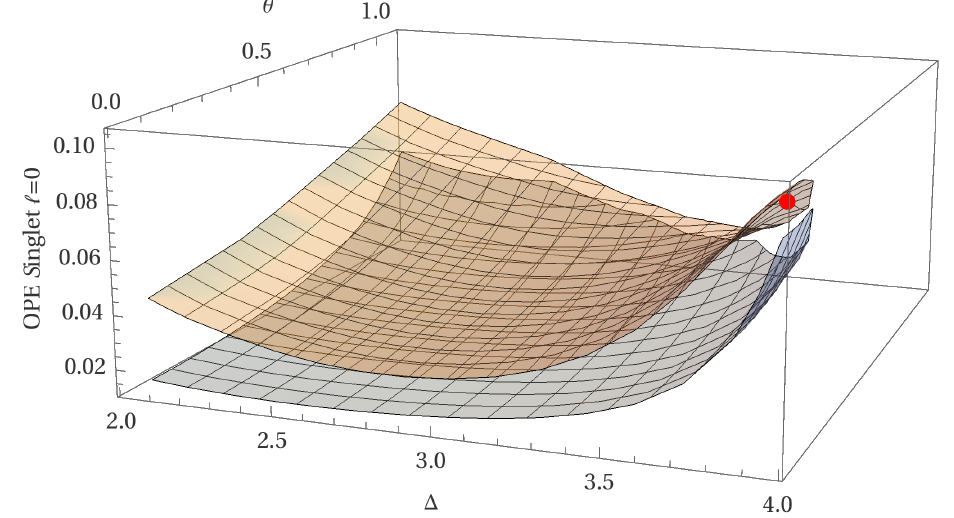
+ λ 2 ) 1 / 2 as a function 22(∆ , 0) 33(∆ , 0)